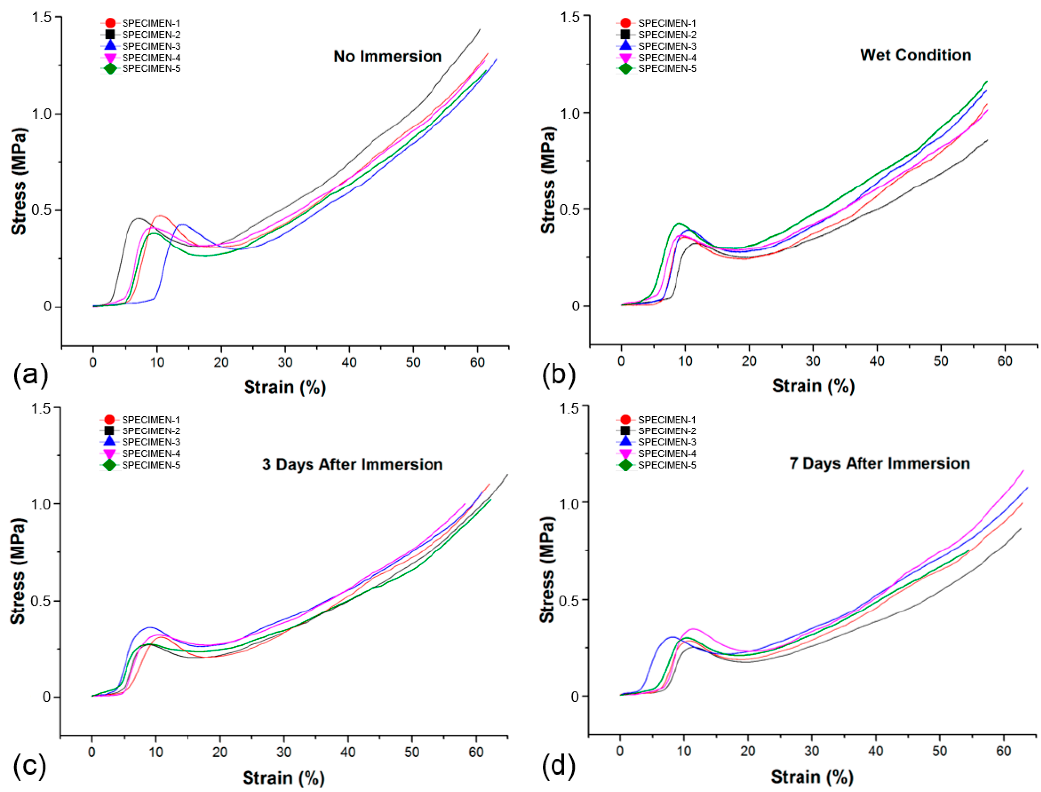
Figure 4. The stress-strain curves of open-cell iron foam specimens with cell diameters of 800 µm: ( a ) no immersion, ( b ) wet conditions, ( c ) three days after immersion, and ( d ) seven days after immersion [27].